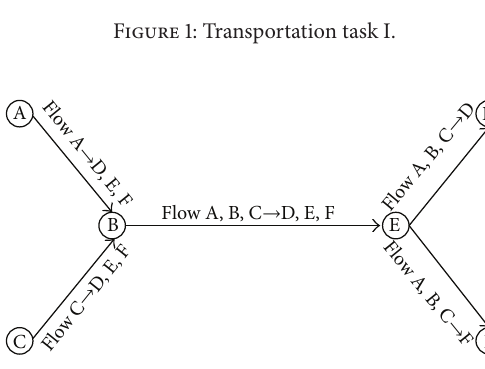
Figure 1: Transportation task I.